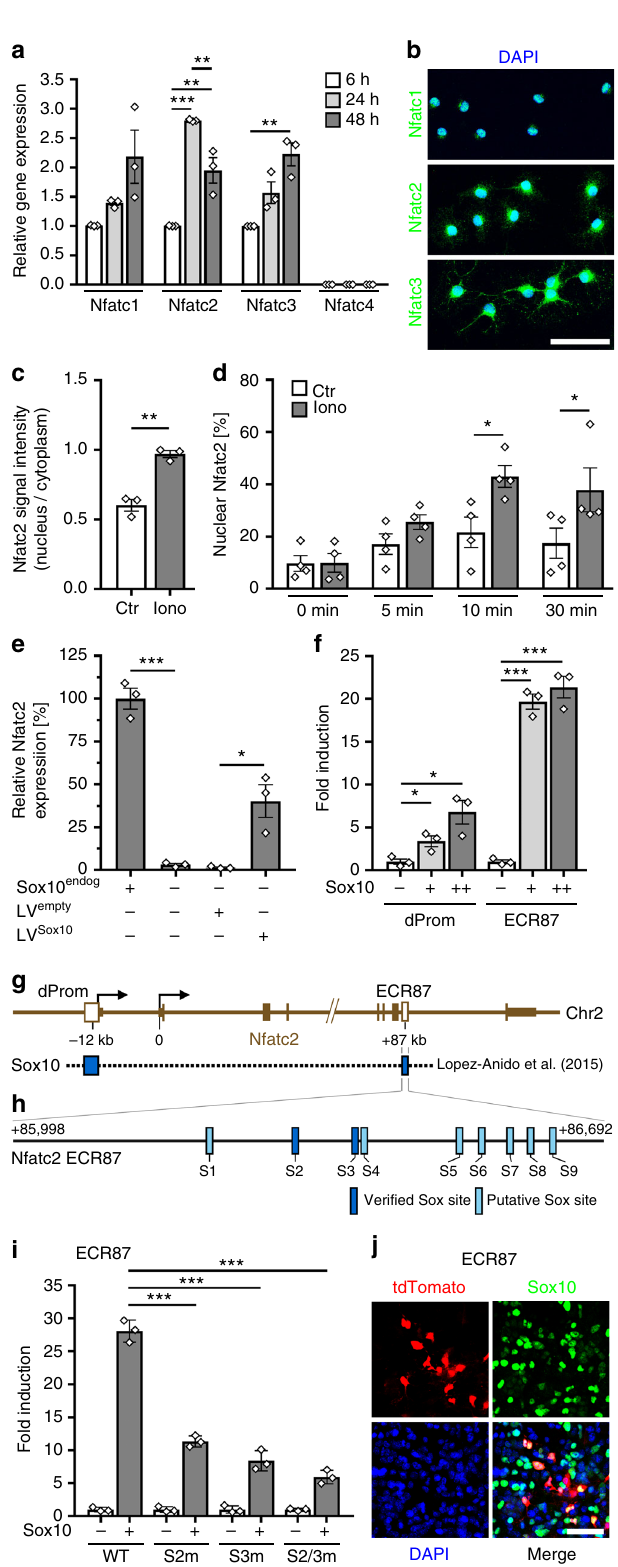
Fig. 3 Nfats are regulated by Sox10 in oligodendroglia. a QrtPCR- determined Rplp0 -normalized Nfat expression in mouse oligodendrocytes after 6 (open bars, set to 1), 24 (light grey bars) or 48 h (dark grey bars) differentiation ( n = 3) ( Nfatc1 : 24 h 1.4 ± 0.1, 48 h 2.2 ± 0.5; Nfatc2 : 24 h 2.8 ± 0.1, 48 h 2.0 ± 0.2; Nfatc3 : 24 h 1.6 ± 0.2, 48 h 2.2 ± 0.2; Nfatc4 : not detected). b Immunocytochemistry on differentiating DAPI-counterstained (blue) mouse oligodendrocytes after 48 h with anti-Nfat antibodies (green). c Nuclear versus cytoplasmic Nfatc2 signal intensity in rat oligodendroglia treated with ionomycin (grey bars, iono) or DMSO (open bars, Ctr) ( n = 3, 30 cells analyzed per experiment) (values: 0.60 ± 0.07 for Ctr, 0.97 ± 0.04 for iono). d Nuclear fraction of Nfatc2-eYFP in transfected mouse oligodendroglial cells before and after treatment with ionomycin or DMSO ( n = 4 with ~40 cells analysed per time point and condition) (values before and after 5, 10, and 30 min treatment: 9.7 ± 3.0%, 17.1 ± 3.9%, 21.6 ± 5.8%, and 17.4 ± 5.8% for Ctr; 9.9 ± 3.6%, 25.5 ± 2.8%, 43.0 ± 4.2%, and 37.9 ± 8.4% for ionomycin). e Gapdh -normalized Nfatc2 quanti fi cation by qrtPCR in wildtype (Sox10 endog + , set to 100%) or Sox10-de fi cient variant +87 kb (Sox10 endog − ) Oln93 cells, before and after transduction with a control (LV empty ) or Sox10-expressing (LV Sox10 ) lentivirus ( n = 3) (wildtype: 100.0 ± 6.1; variant: 3.1 ± 0.8; LV empty -infected variant: 1.5 ± 0.4; LV Sox10 -infected variant: 40.3 ± 9.6). f Sox10-dependent ( + , light grey bars = low amounts; ++ , dark grey bars = high amounts) fold inductions ± SEM of luciferase reporters carrying Nfatc2 distal promoter (dProm) or ECR87 in transfected Verified Sox site Putative Sox site N2a cells after 48 h ( n = 3) (dProm: 3.4 ± 0.6 and 6.8 ± 1.4; ECR87: 19.7 ± 0.9 and 21.4 ± 1.3). g Mouse Nfatc2 locus with exons (brown boxes), transcription start sites (arrows), and Sox10 ChIP-Seq peaks (blue boxes). h Putative (light blue) and EMSA-con fi rmed (dark blue) Sox10 binding sites in ECR87. i Sox10-dependent ( + , grey bars) fold inductions ± SEM of wildtype or mutant ECR87 luciferase reporters with inactivated Sox10 binding sites (S2m, S3m, S2/3m) in transfected N2a cells after 48 h ( n = 3) (WT: 28.1 ± 1.0; S2m: 11.3 ± 0.5; S3m 8.4 ± 0.9; S2/3m 5.9 ± 0.6). j Sox10 immunohistochemistry (green) on cortical slices 7 days after transduction with a retroviral ECR87-tdTomato reporter (red). DAPI counterstain in blue. Scale bars, 50 µ m. Statistical signi fi cance was determined by Bonferroni- corrected one-way ( a ) or two-way ANOVA ( d ) and two-tailed Student ’ s t - test ( c , e , f , i ) (* P ≤ 0.05; ** P ≤ 0.01; *** P ≤ 0.001)